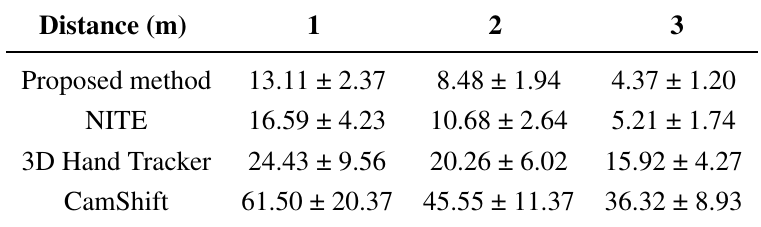
Table 3. Averaged errors in the pixel and the standard deviations of our method in comparison with Natural Interaction Technology for End-user (NITE), 3D Hand Tracker with depth images and CamShift, at different distances (1 m, 2 m and 3